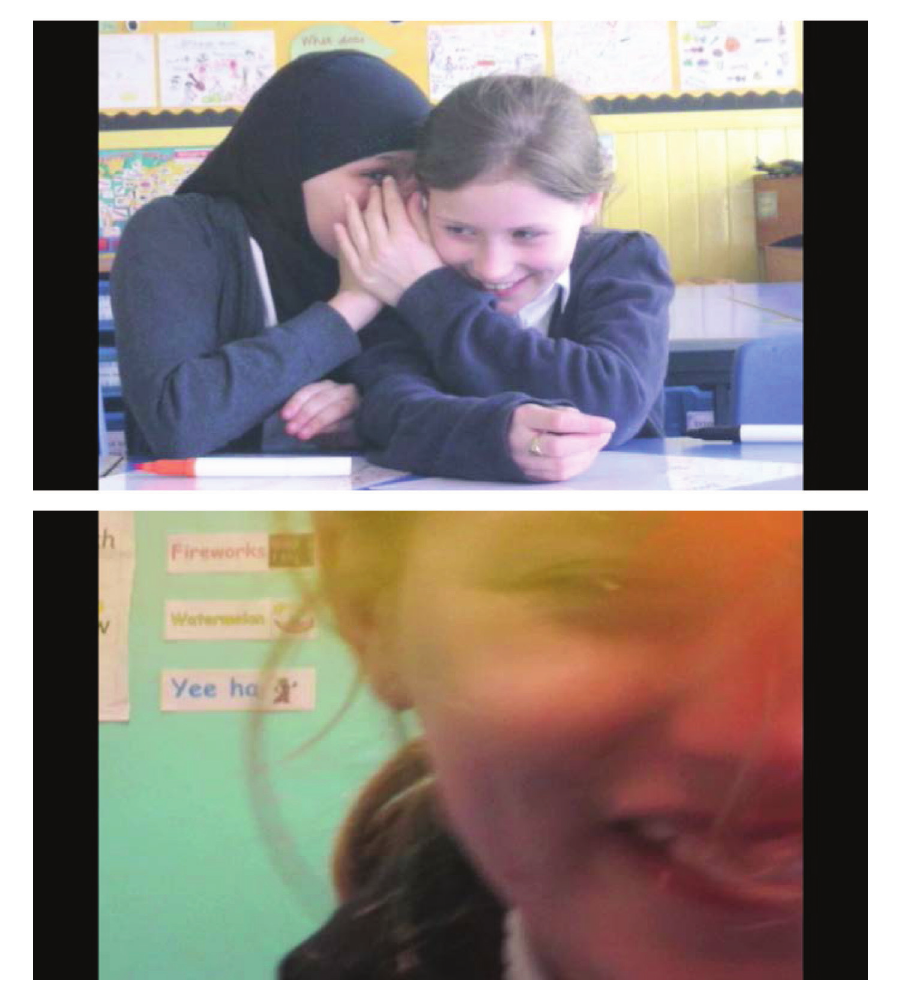
Figure 1–2: Some of the film club’s early exercises exploring the theme of